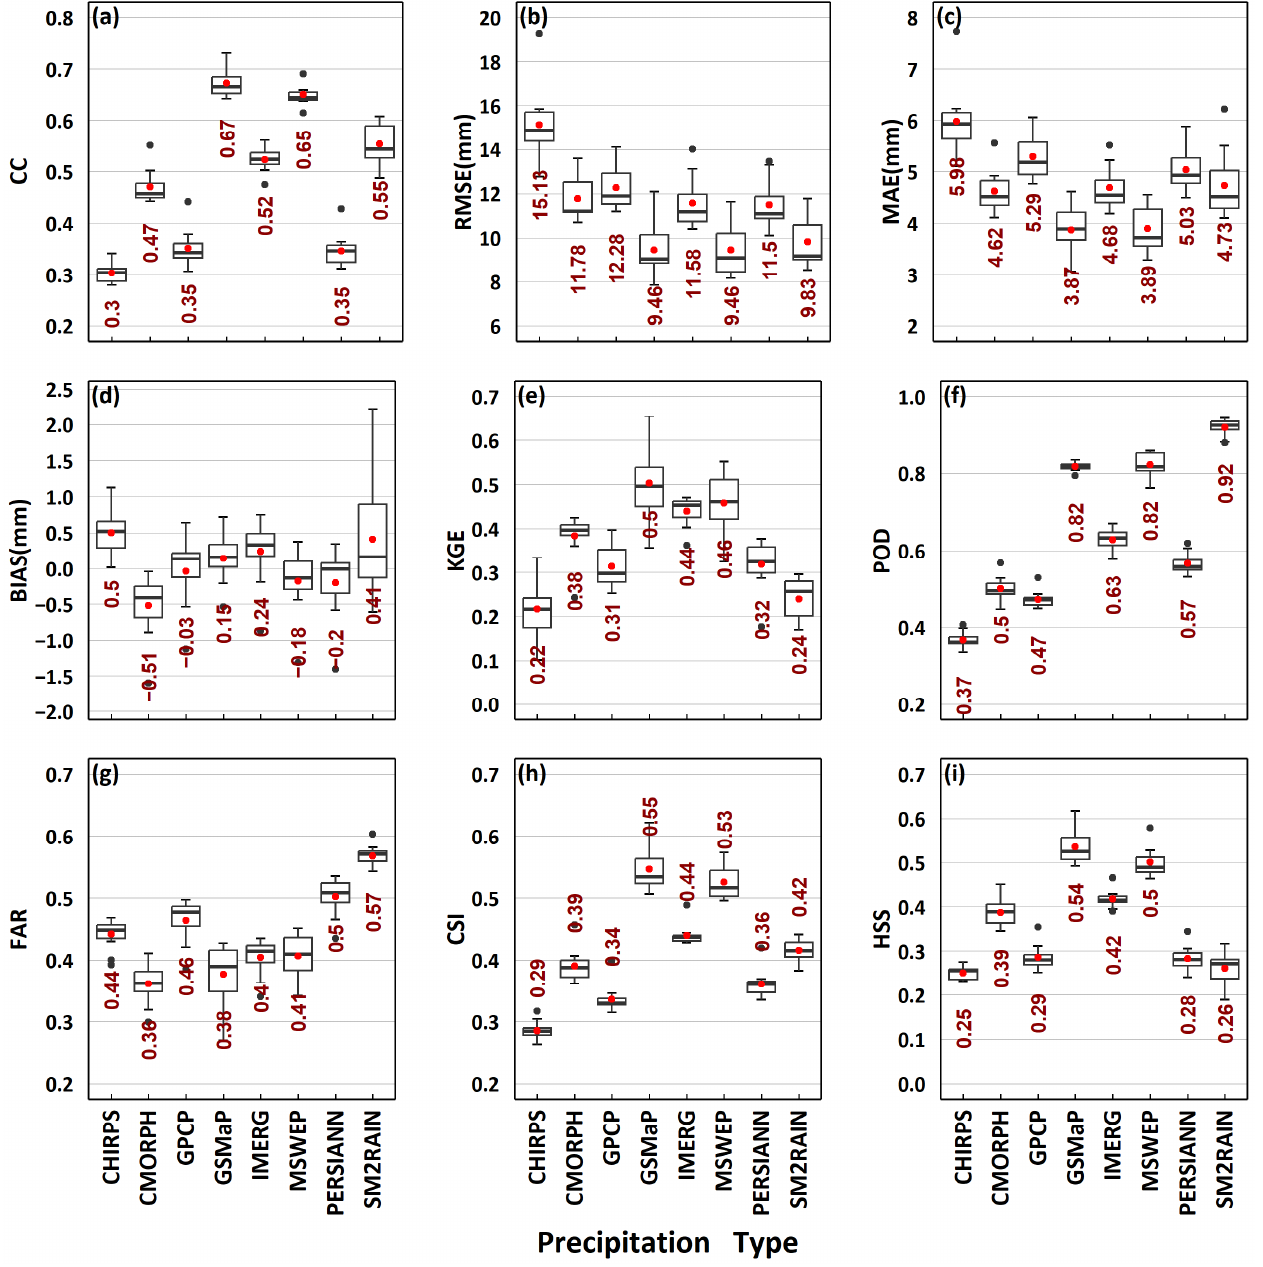
Figure 2. Boxplots of evaluation indices ( a ) CC, ( b ) RMSE, ( c ) MAE, ( d ) BIAS, ( e ) KGE, ( f ) POD, ( g ) FAR, ( h ) CSI, and ( i ) HSS for SPPs at grid scale from 2007 to 2020. The labelled red dot represents the mean value, and the black dots represent outliers.